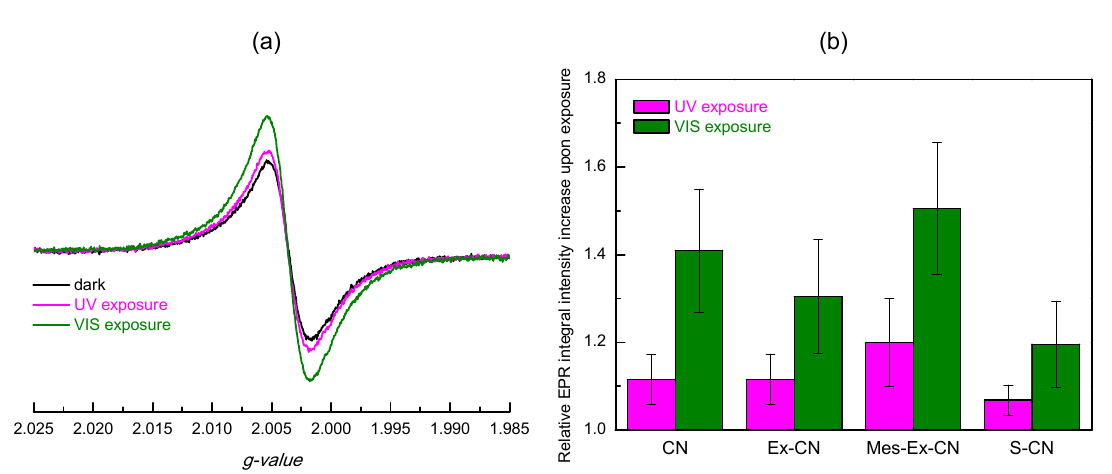
Figure 10. ( a ) EPR spectra obtained before and upon continuous ultraviolet A (UVA) ( λ max = 365 nm) and VIS ( λ > 420 nm) exposure of the CN powder sample at room temperature. ( b ) Relative EPR integral intensity increase monitored upon UVA and VIS exposure of the studied powder samples at room temperature.